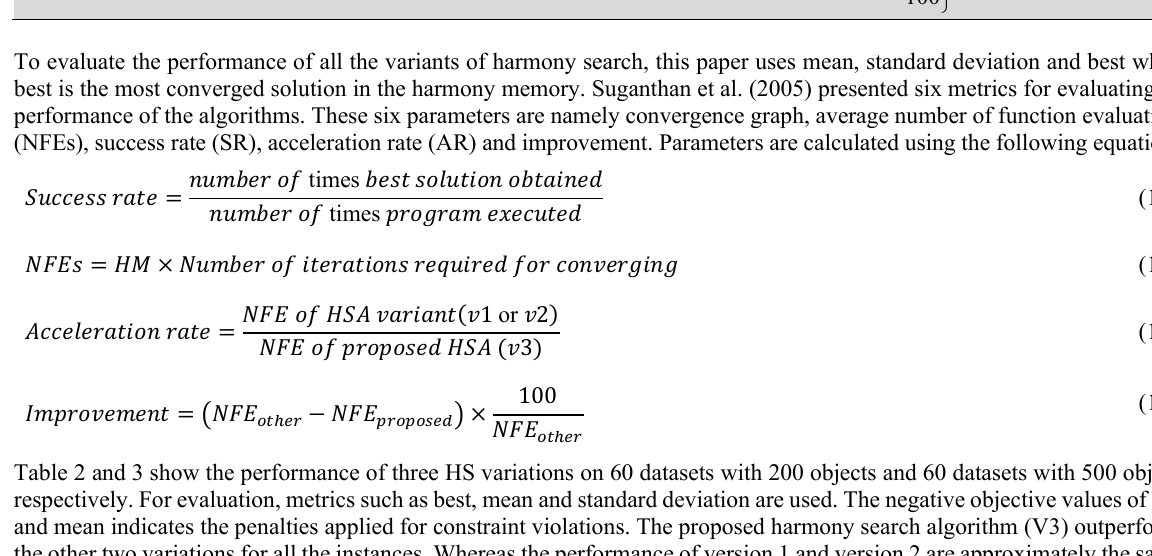
Table 1 Input format of the benchmark instances 500 ← Number of objects